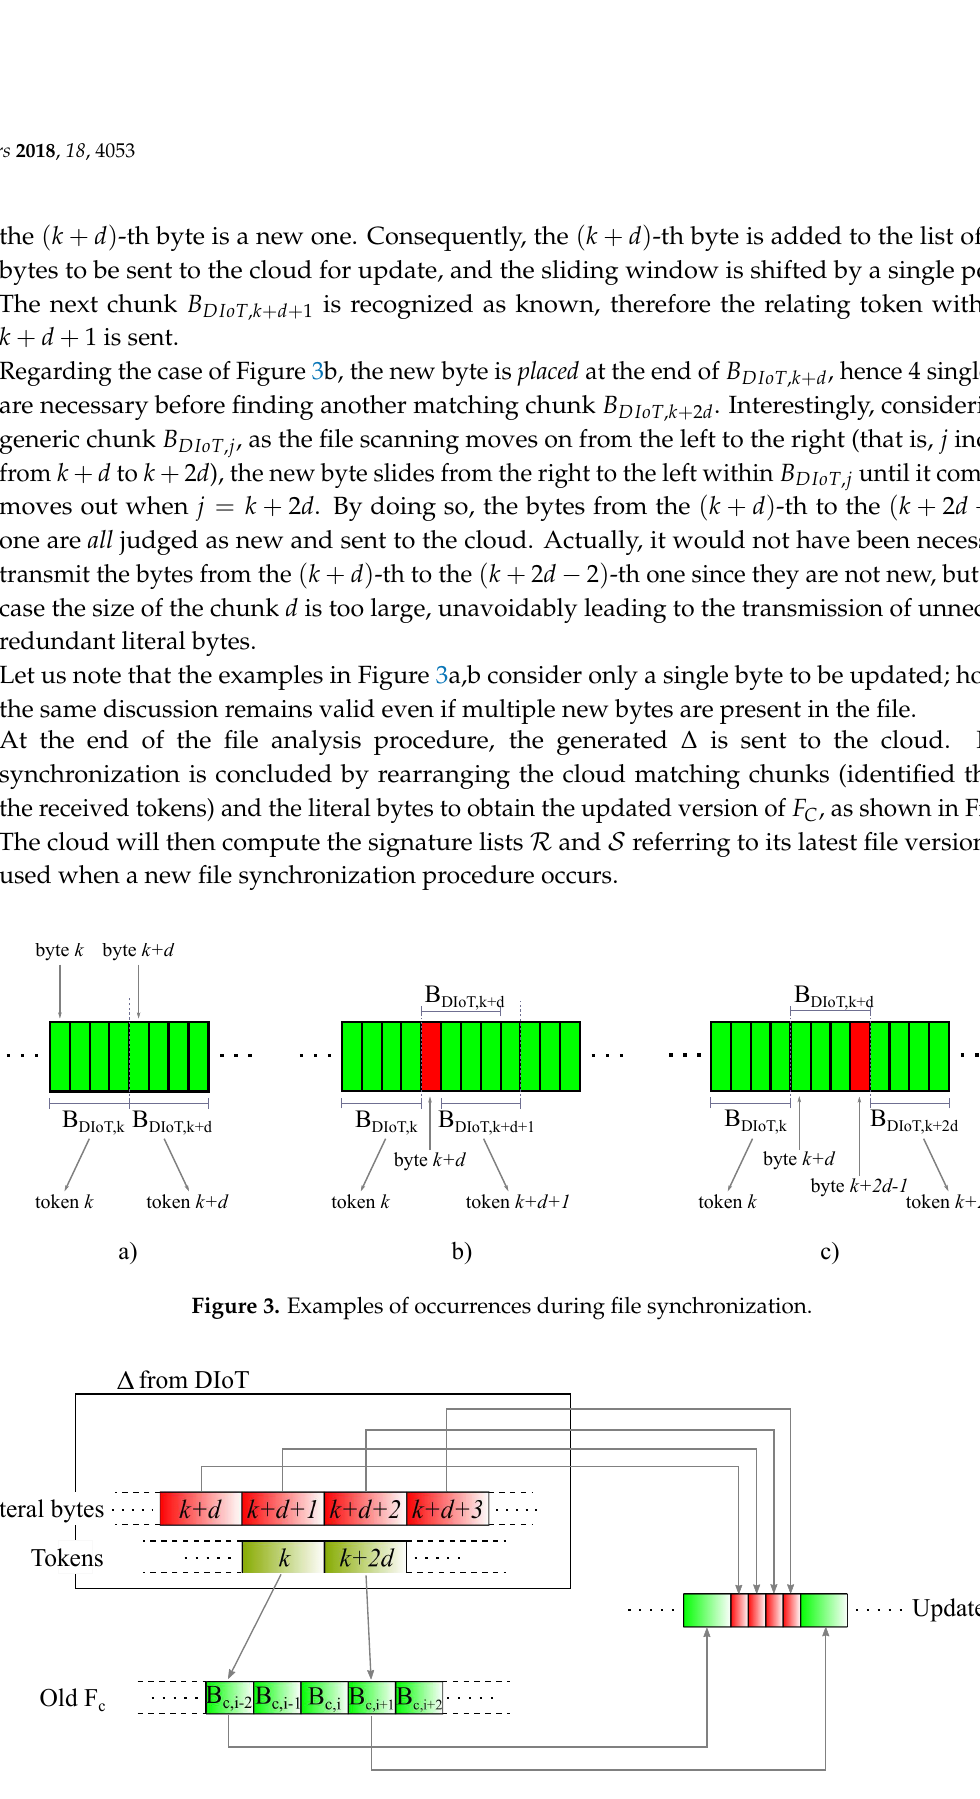
Figure 4. Cloud file update according to the scenario in Figure